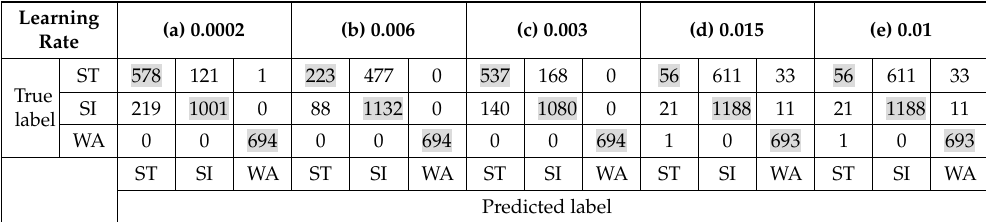
Table 10. Confusion matrices: (OR + LA1 + SH + LA2)—200-feature vector dataset.